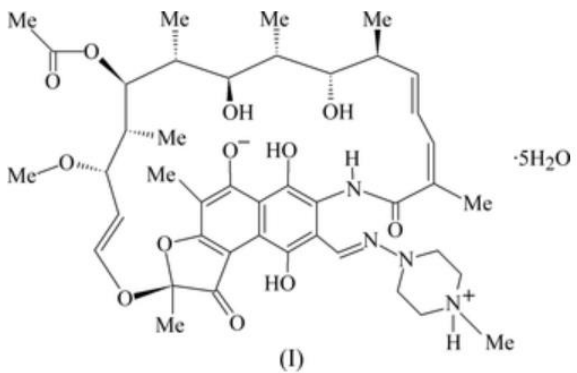
Figure 20. Structure of rifampicin taken from Ref. [85]. Reproduced with permission of the Interna- tional Union of Crystallography.